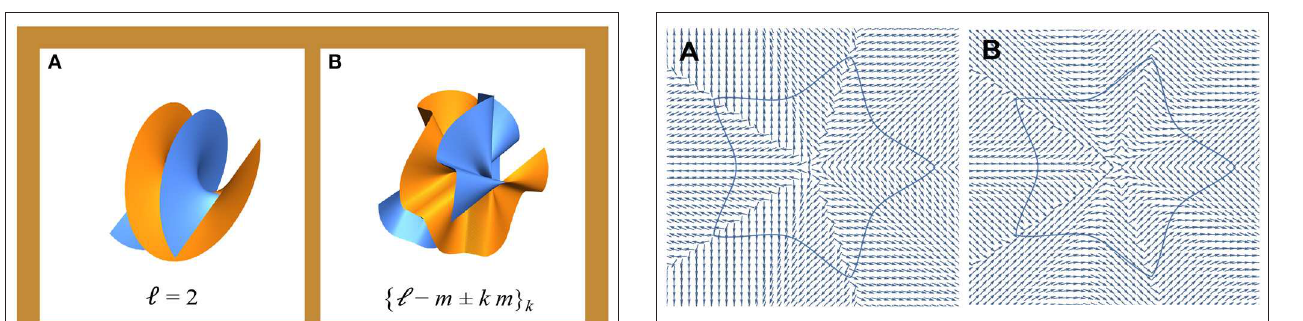
FIGURE 4 | Optic axis patterns deduced from Equation (7) for the parameter b n 3 values a 1, m 5, n 1 1 / 2, and n 2 4 / 3. (A) Optic axis pattern = = = = = = for a SVAP imparting to an input beam the geometric phase 2 φ 2 12 m ( φ ) + ( Figure 1B ). (B) Optic axis pattern for a SVAP imparting the geometric phase 2 12 m ( φ ) ( Figure 1C